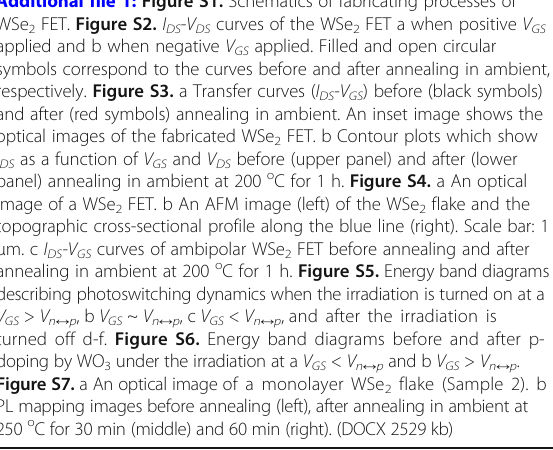
Abbreviations 2D: Two-dimensional;; AFM: Atomic force microscopy; FET: